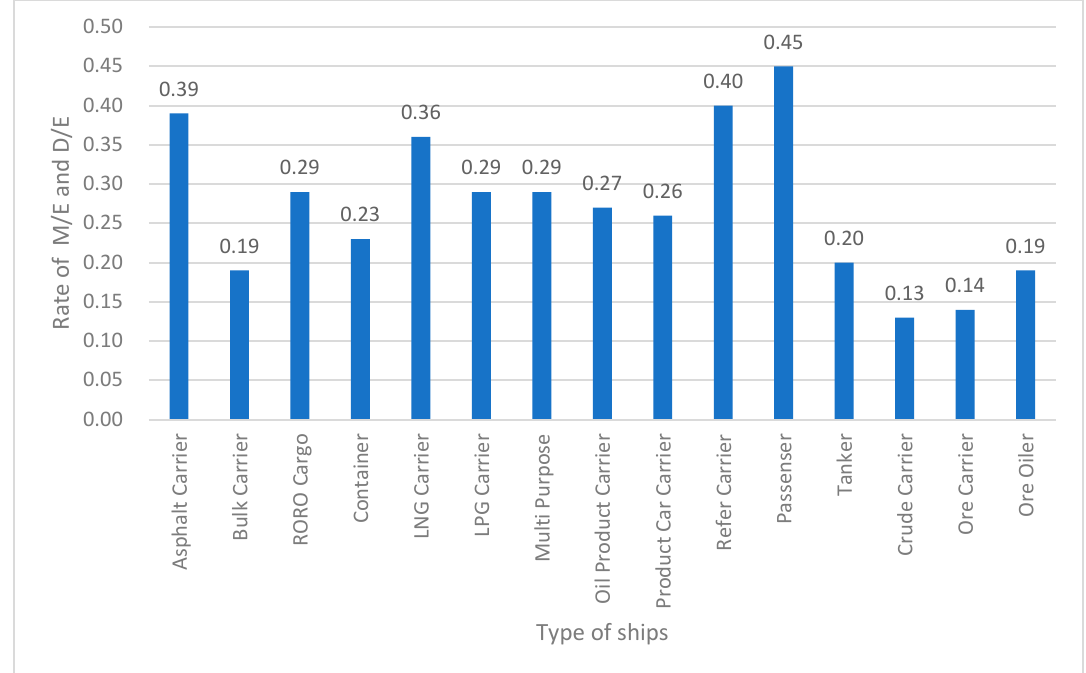
Figure 6. Estimated average ship ratio of auxiliary engine and main engine.